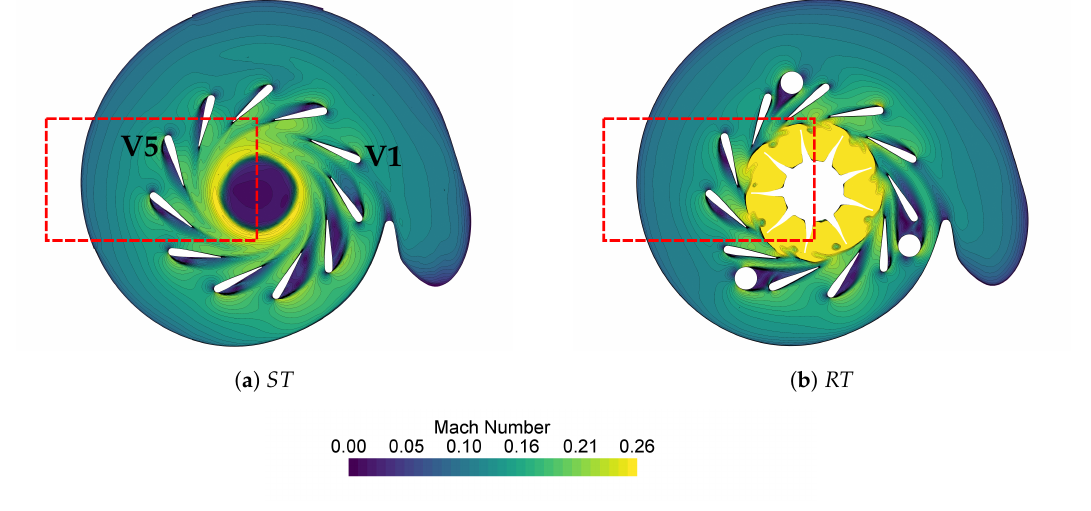
Figure 6. Global Mach number distribution at the stator